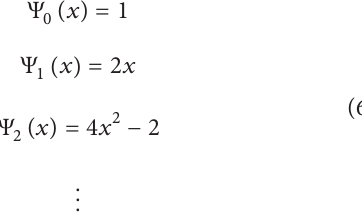
Because 𝜉 ∼ N (0, 1/2) , the related set {Ψ 𝑖 (𝑥)} 𝑖∈ N is represented by the family of Hermite polynomials defined on the whole real line; namely, 𝐷 = R ,